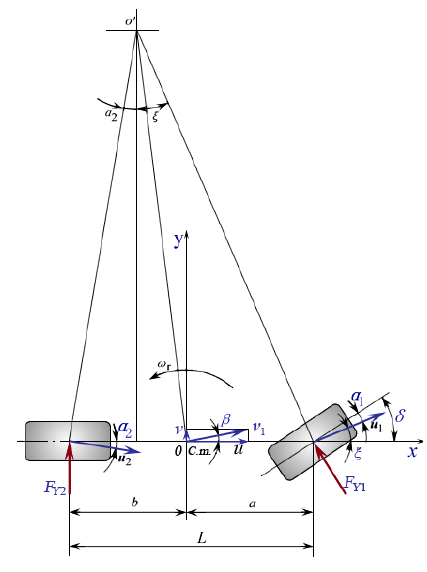
Figure 2. Bicycle model.